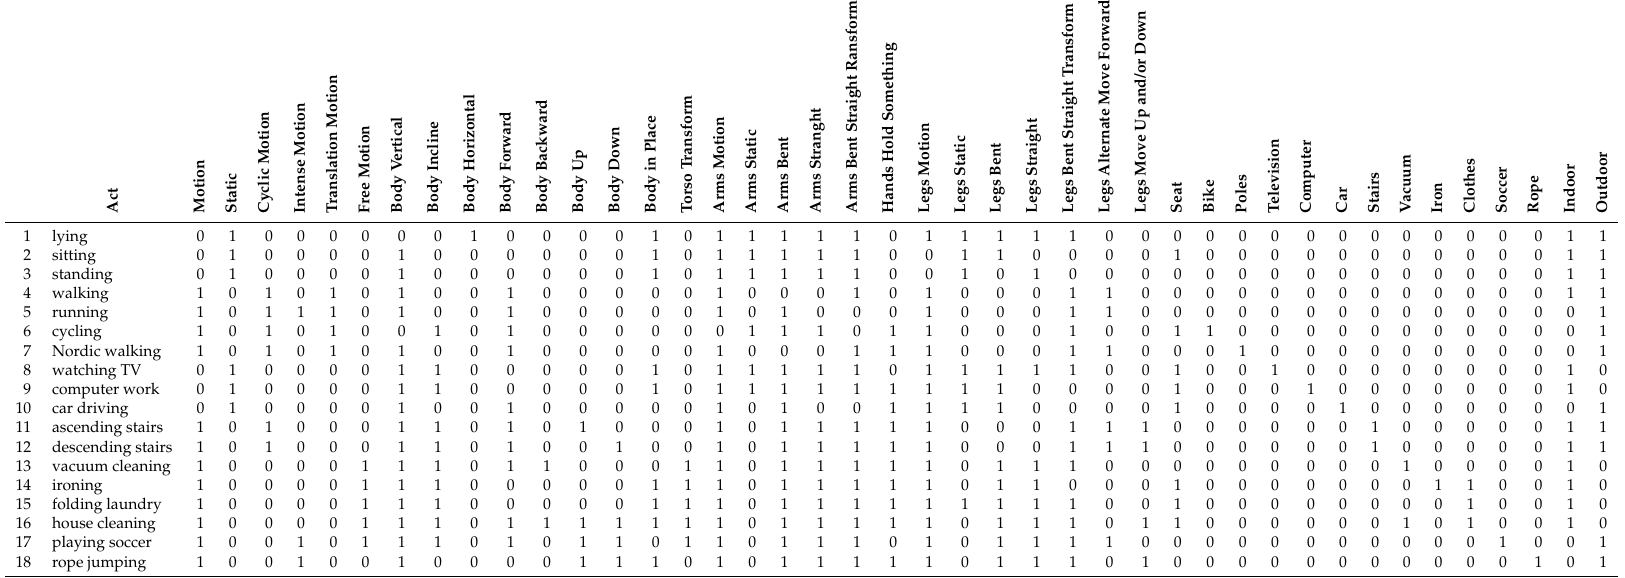
Table A2. Attribute vectors of the PAMAP dataset from